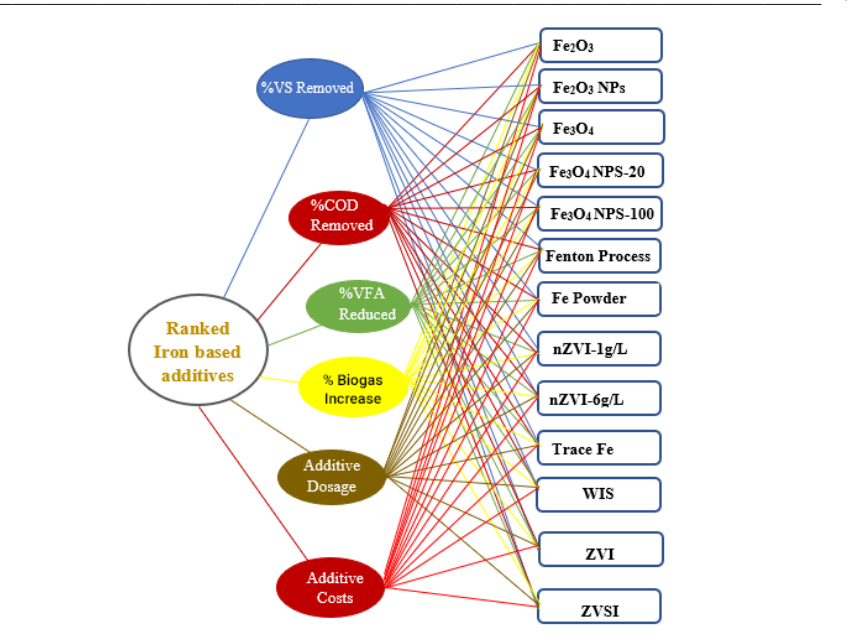
Fig. 1. Decision matrix chart for ranked iron-based additives